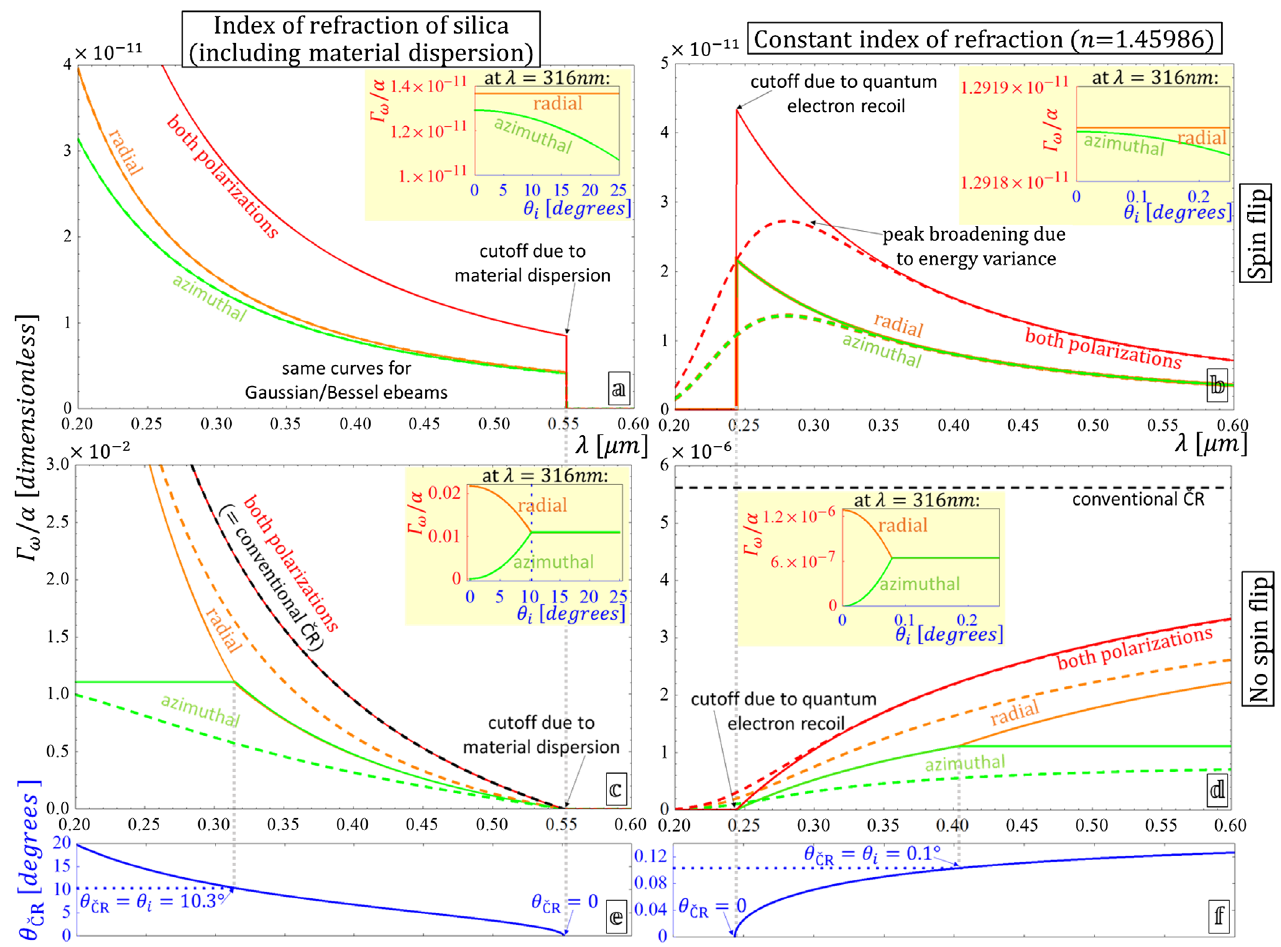
FIG. 3. Deviations between classical and quantum Č R theories — conventional vs QED photon emission rates, demonstrated with Bessel ebeams (solid curves) and Gaussian ebeams (dashed curves). Dashed black lines: Conventional Č R result, according to Frank- Tamm [Eq. (1b)]. Green and orange lines: Quantum Č R for emission into azimuthal and radial polarizations, according to Eq. (S41) (red curve is for their sum). Blue line: The Č erenkov angle [in (e) and (f)], showing a spectral cutoff where it becomes zero and spectral kinks where it crosses θ i , both marked by gray dotted lines. Unlike the conventional Č erenkov theory, the quantum theory predicts Č R that involves electron spin flip [panels (a) and (b)] having discontinuities at both cutoffs. The dominant part of the Č R emission [no spin flip, panels (c) and (d)] matches the conventional theory in (c) but deviates from it near ω in (d). The kinks (abrupt change in slope), cutoff which are also emphasized in the insets, are a unique feature of the Bessel ebeam that is smoothened out in Gaussian ebeams — compare solid and dashed curves in (c) and (d). For the current choice of parameters, panels (a) and (b) are practically agnostic to θ i . Panels (a) and (c) present Č R in silica for a Bessel ebeam with θ i ¼ 10 . 3 ° or Gaussian with spread FWHM of 10.3°, both showing a “ trivial ” spectral cutoff at λ ¼ 550 nm (occurs since n drops below 1 = β ). Panels (b) and (d) present Č R assuming a constant n ¼ 1 . 45986 for a Bessel ebeam with θ i ¼ 0 . 1 ° or Gaussian with spread FWHM of 0.1°, both showing a new spectral cutoff at λ ¼ 244 nm [occurs because of the quantum correction to Č R from electron recoil, as shown by ω in Eq. (5)]. A different choice of n causes ω to shift, yet its cutoff cutoff exact value only matters at the proximity of the cutoff: no need for a constant n over a wide spectrum. All ebeams have β ¼ 0 . 685 ( ∼ 190 keV); while the Bessel ebeams are mono-energetic, the Gaussians have an energy uncertainty of Δ E ¼ 0 . 5 eV. The predicted effects are not special for the current choice of